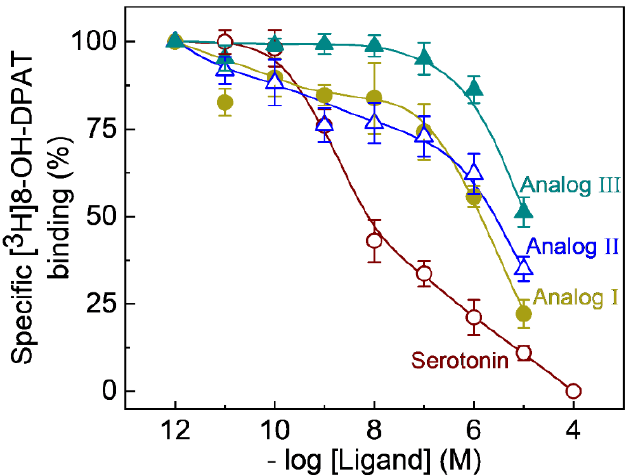
Figure 2. Competition binding of fluorescent NBD-labeled serotonin ligands to the human serotonin 1A receptor stably expressed in CHO-K1 cells. Radioligand binding assays were carried out with [ 3 H]8-OH-DPAT in the presence of a range of concentrations (from 10 − 12 to 10 − 4 M) for serotonin ( ○ ) and NBD-labeled analogs I (●), II (Δ) and III ( ▲ ). Values of specific binding measured in the pres- ence of fluorescent analogs are expressed as a percentage of total binding obtained at the lowest concentration of the competing ligand. The curves represent nonlinear regression fits to the ex- perimental as described in the Supplementary Material. Data shown are means ± SE from five in- dependent experiments. Nonspecific binding was determined in the presence of 10 −4 M unlabeled serotonin in each case. K i values were determined according to Cheng and Prusoff [60] and the average values are listed in Table 1. See Materials and Methods for other details. Table 1. IC 50 and K i values of fluorescent NBD-labeled serotonin analogs for binding to seroto- nin 1A receptors stably expressed in CHO-K1 cells a .